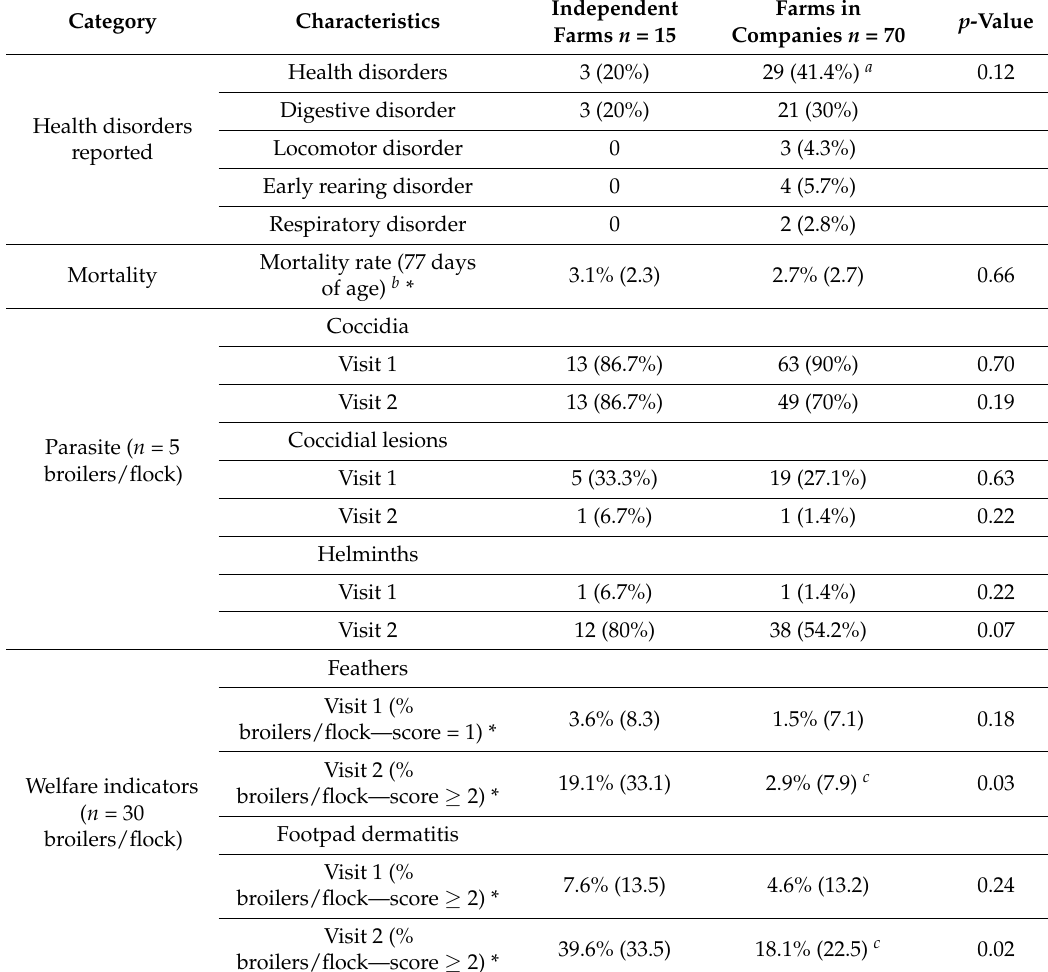
Table 4. Health and welfare characteristics of the organic broiler flocks ( n = 85, France,